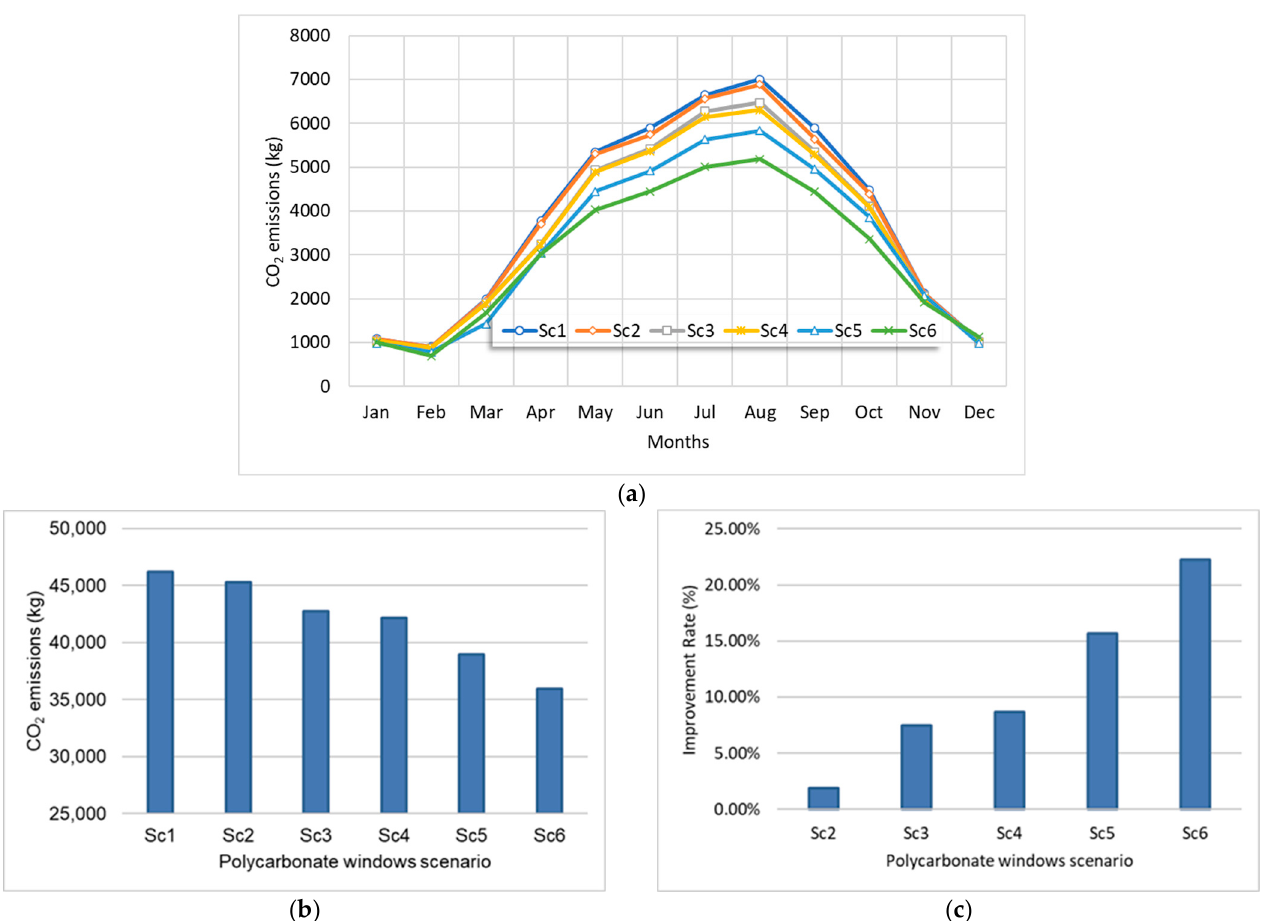
Figure 8. The simulation outcomes for each proposed polycarbonate window scenario in terms of ( a ) monthly CO 2 emissions, ( b ) annual CO 2 emissions, and ( c ) the improvement rate.